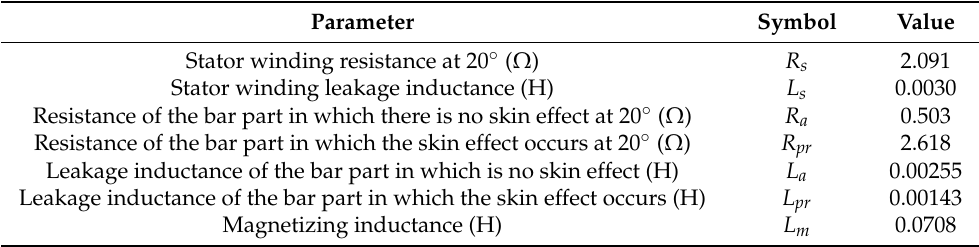
Table 2. Parameters of the equivalent circuit of the investigated induction motor.